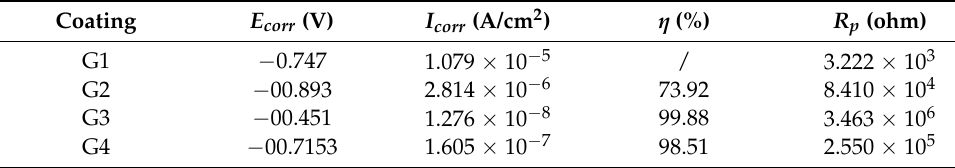
Table 2. Kinetic parameters of each